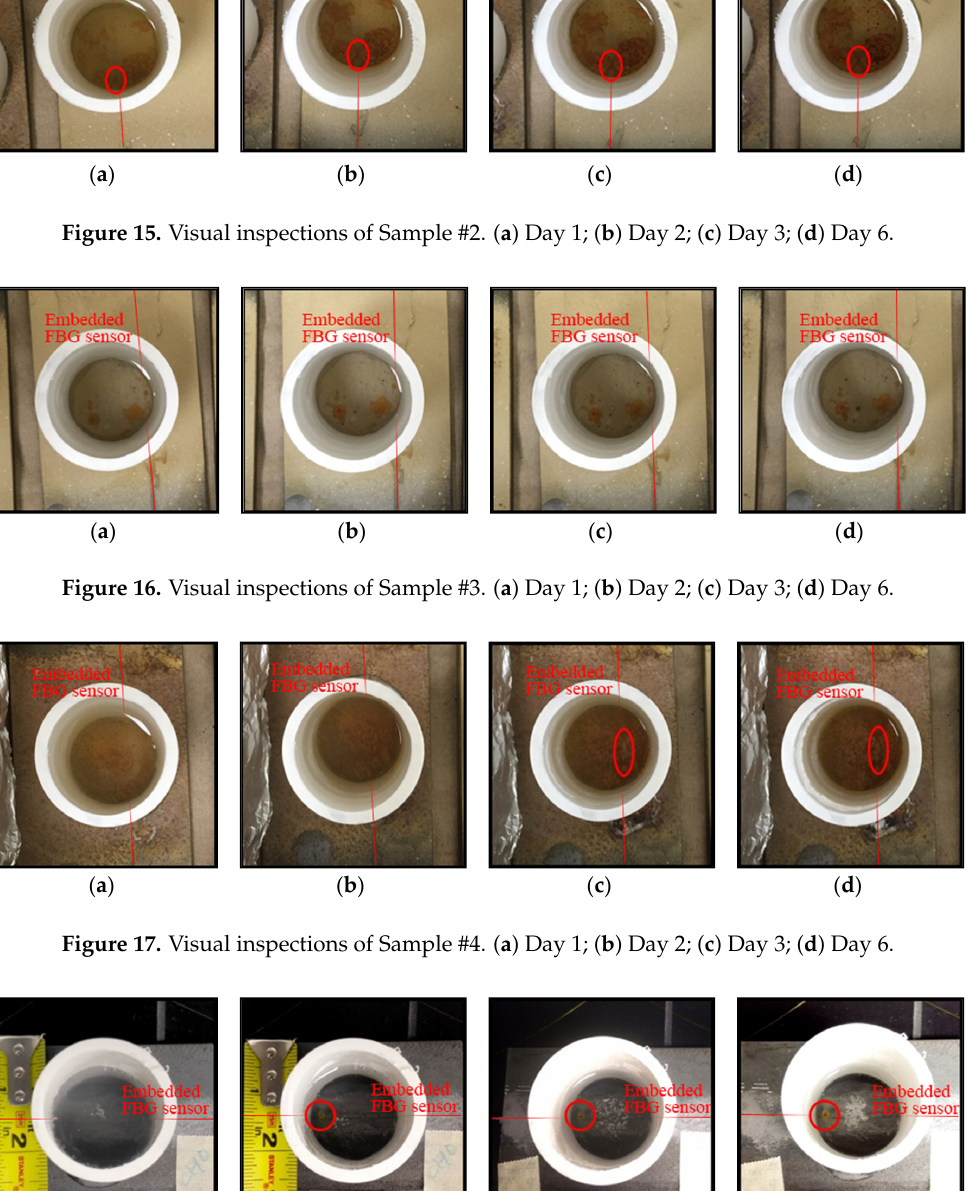
Figure 14. Visual inspections of Sample #1. ( a ) Day 1; ( b ) Day 2; ( c ) Day 3; ( d ) Day 6.